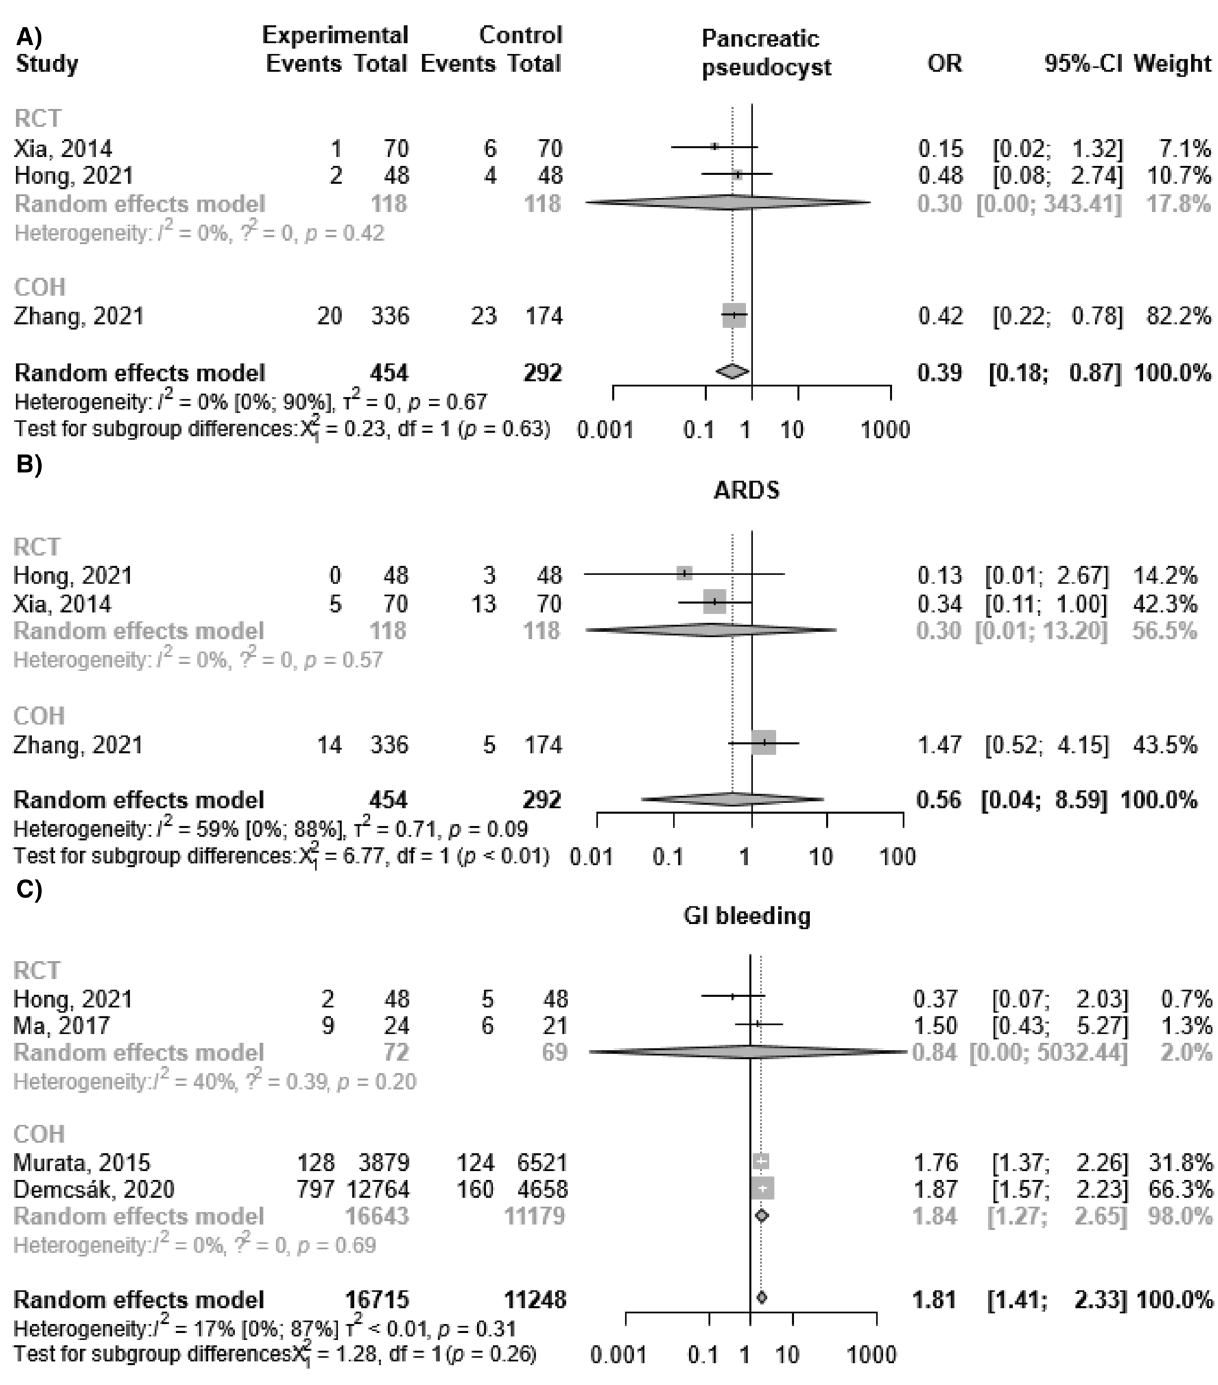
Figure 2. The addition of proton pump inhibitor treatment to standard of care in acute pancreatitis was associated with: ( A ) decreased pancreatic pseudocyst development rate; ( B ) no significant difference regarding development of ARDS; ( C ) increased odds of GI bleeding. OR odds ratio, CI confidence interval, RCT randomized controlled trial, COH cohort study, ARDS Acute Respiratory Distress Syndrome, GI